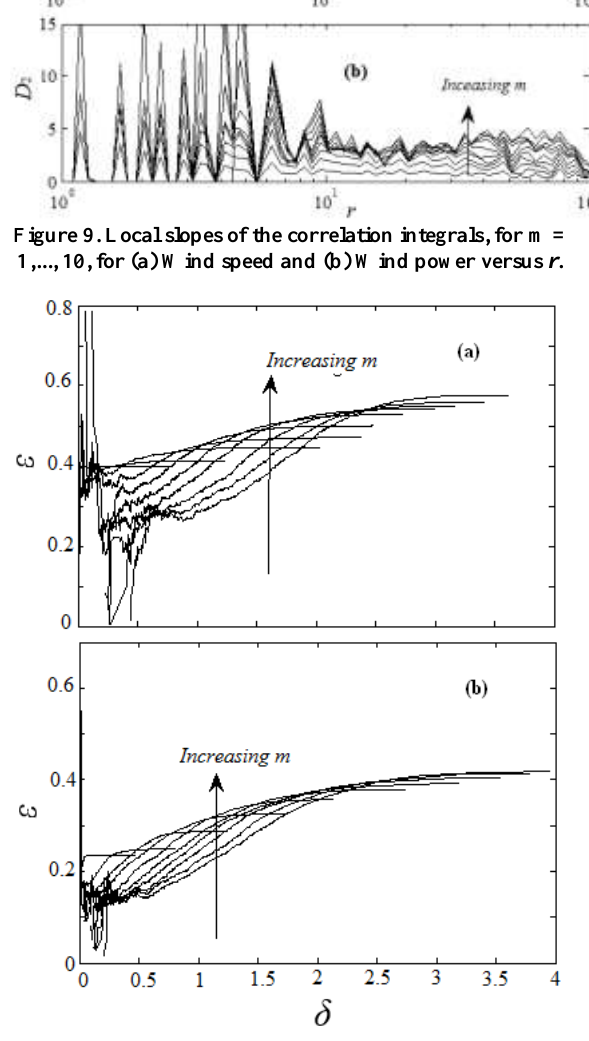
Figure 10. Results for the δ-ε method for (a) wind speed and (b) wind